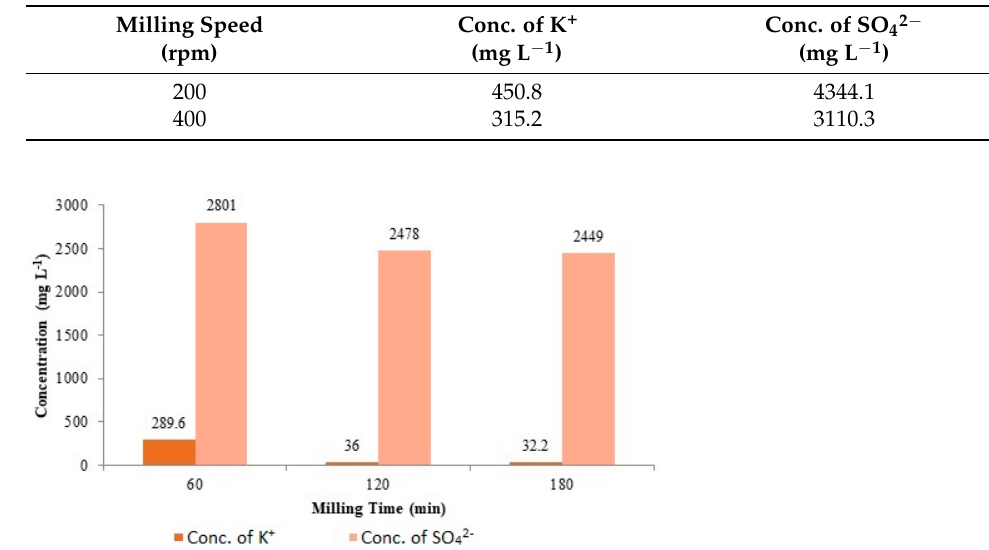
Table 3. The concentration of K + and SO 42 − nutrients released from kaolinite-K 2 SO 4 mixture milled at different rotational speeds for 120 min.